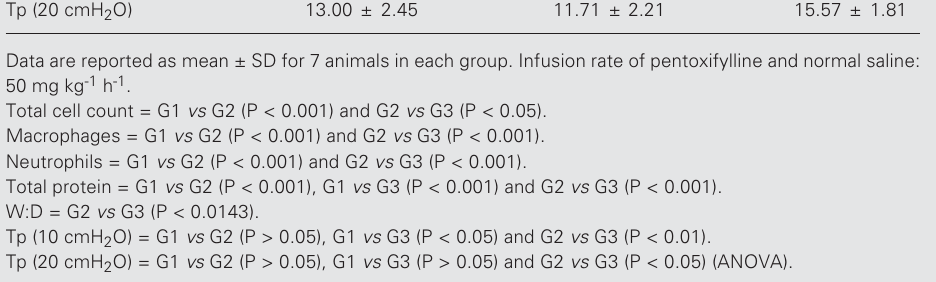
Table 1. Effect of pentoxifylline on total cell count, macrophages, neutrophils and total protein in bronchoalveo- lar lavage, wet-to-dry ratio (W:D), and transpulmonary pressure (Tp) in 10 and 20 cmH 2 O. G1 G2 G3 Total cells (cells/mm 3 )